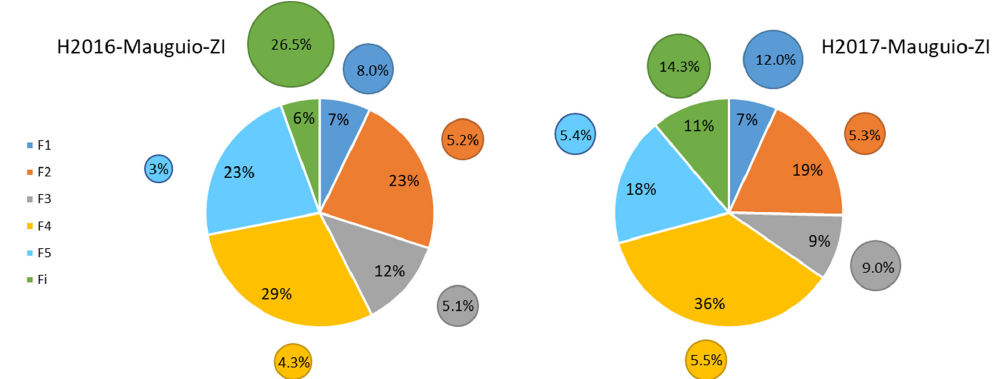
Figure 2. Comparison of 2 years (H2016, left ; H2017, right ), same cropping system (ZI) and same location (Mauguio). Proportion of the different protein fractions (F1 to Fi) in lab-milled grains. The size of the small outer circles is proportional to the varietal coefficient of variation of each fraction.